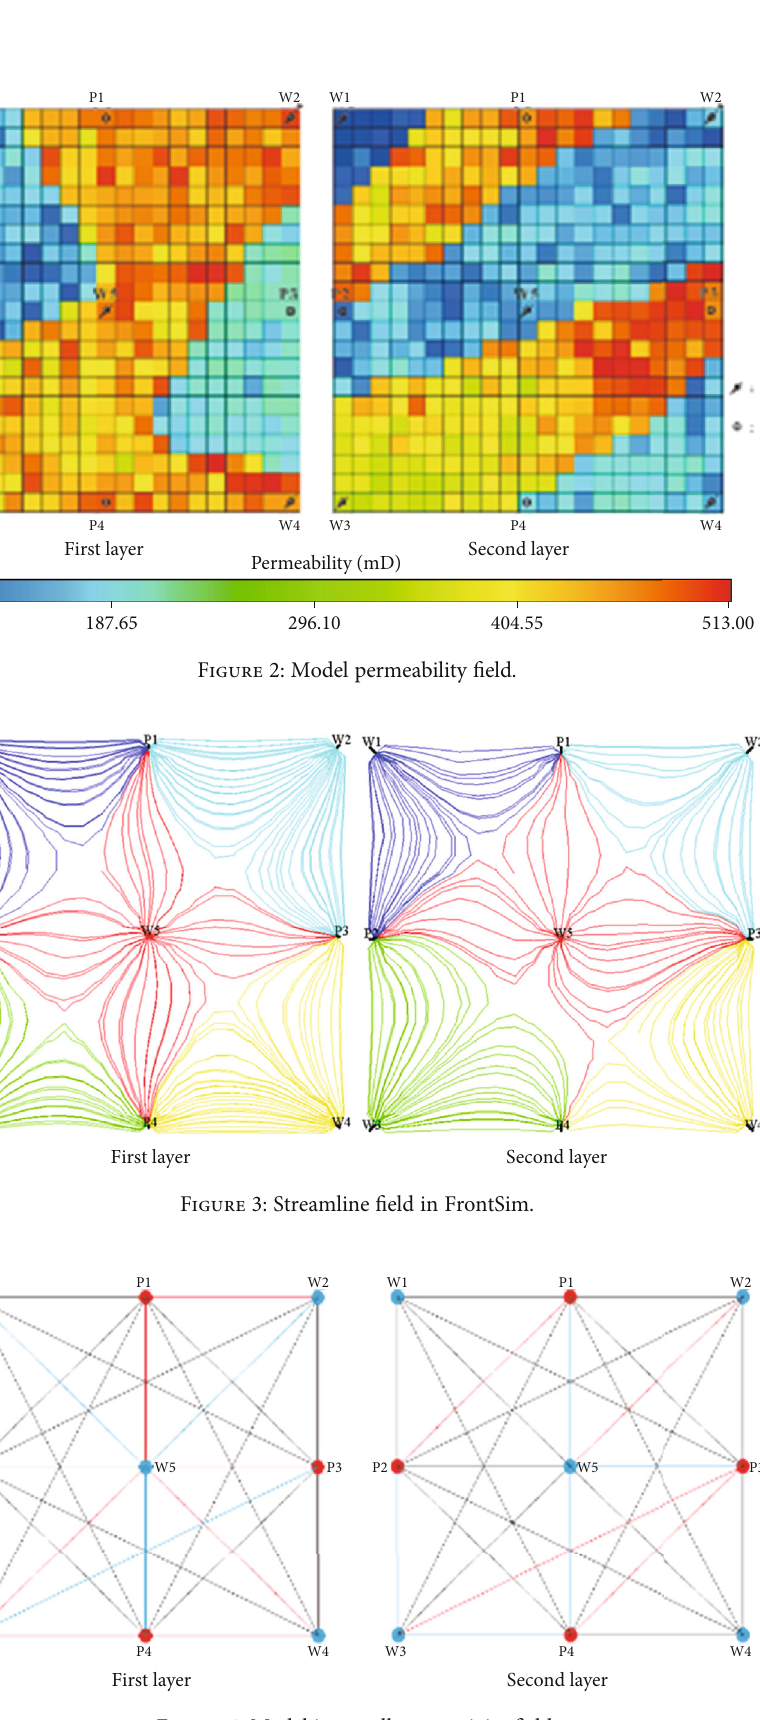
Figure 4: Model interwell connectivity fi eld.